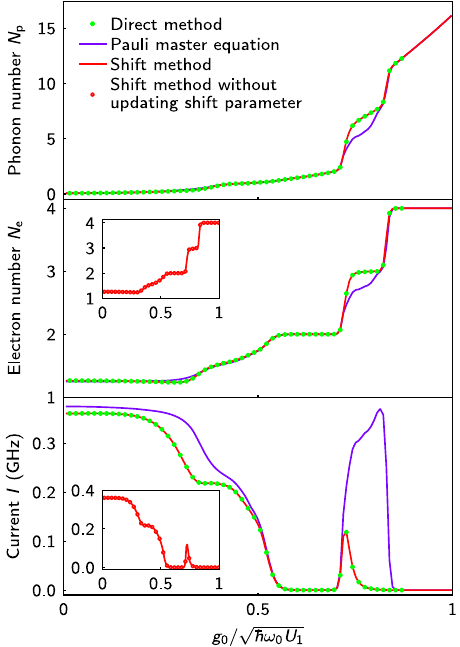
Fig. 6 Comparison between different methods for solving the steady state. Here we choose a large fundamental frequency π = 80 GHz such that the phonon number in the system is small. ω 0 /2 We truncate the phononic Hilbert space to a fi nite-dimensional Hilbert space with maximal 30 (or 100) phonons for the direct method (or Pauli master equation approach). On the other hand, the shift methods with and without updating the shift parameter are performed within a Hilbert space with maximal 5 tilded phonons. Here we set eV bias /2 π ℏ = 100 GHz, and other parameters are the same as in Fig.